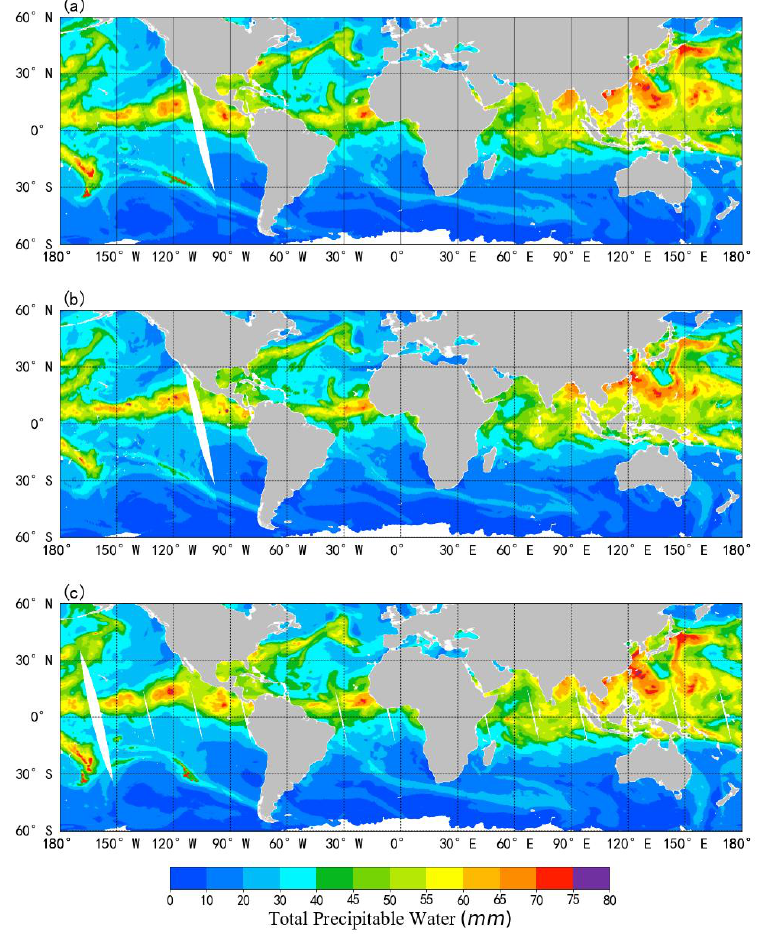
Figure 13. TPW retrieved from MWTS-III and ATMS over global oceans on 1 August 2021. ( a , c ) The cloud liquid water path retrieved from of MWTS-III and ATMS using the physical algorithm; ( b ) TPW from ERA5 reanalysis at the time of MWTS-III.